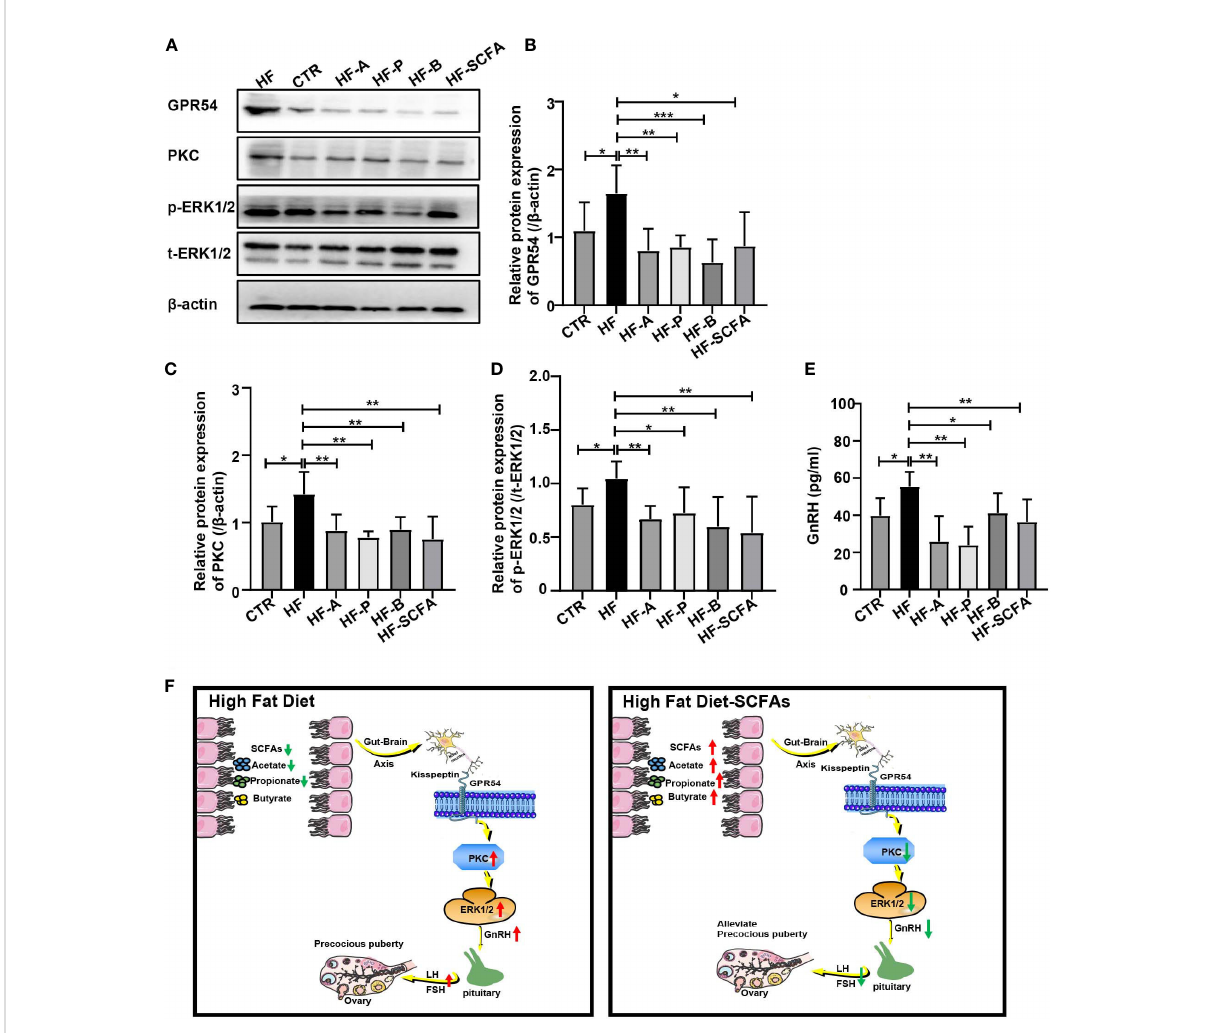
FIGURE 8 SCFAs regulate hypothalamic GnRH release through GPR54-PKC-ERK1/2 pathway. (A) Representative Western blot images showing GPR54, PKC, p-ERK1/2, t-ERK1/2 and b -actin expression in rats added with SCFAs. (B – D) Statistical analysis of GPR54, PKC and p-ERk1/2 expression in each group. (E) GnRH secretion in the hypothalamus. (F) HFD led to a decrease in SCFAs in the gut and promoted the expression of the GPR54- PKC-ERK1/2 pathway. Supplementation with SCFAs with a HFD reversed the high expression of the GPR54-PKC-ERK1/2 pathway and further decreased the secretion of GnRH, weakening the activation of the pituitary gland and inhibiting gonadal development. n = 6 per group for